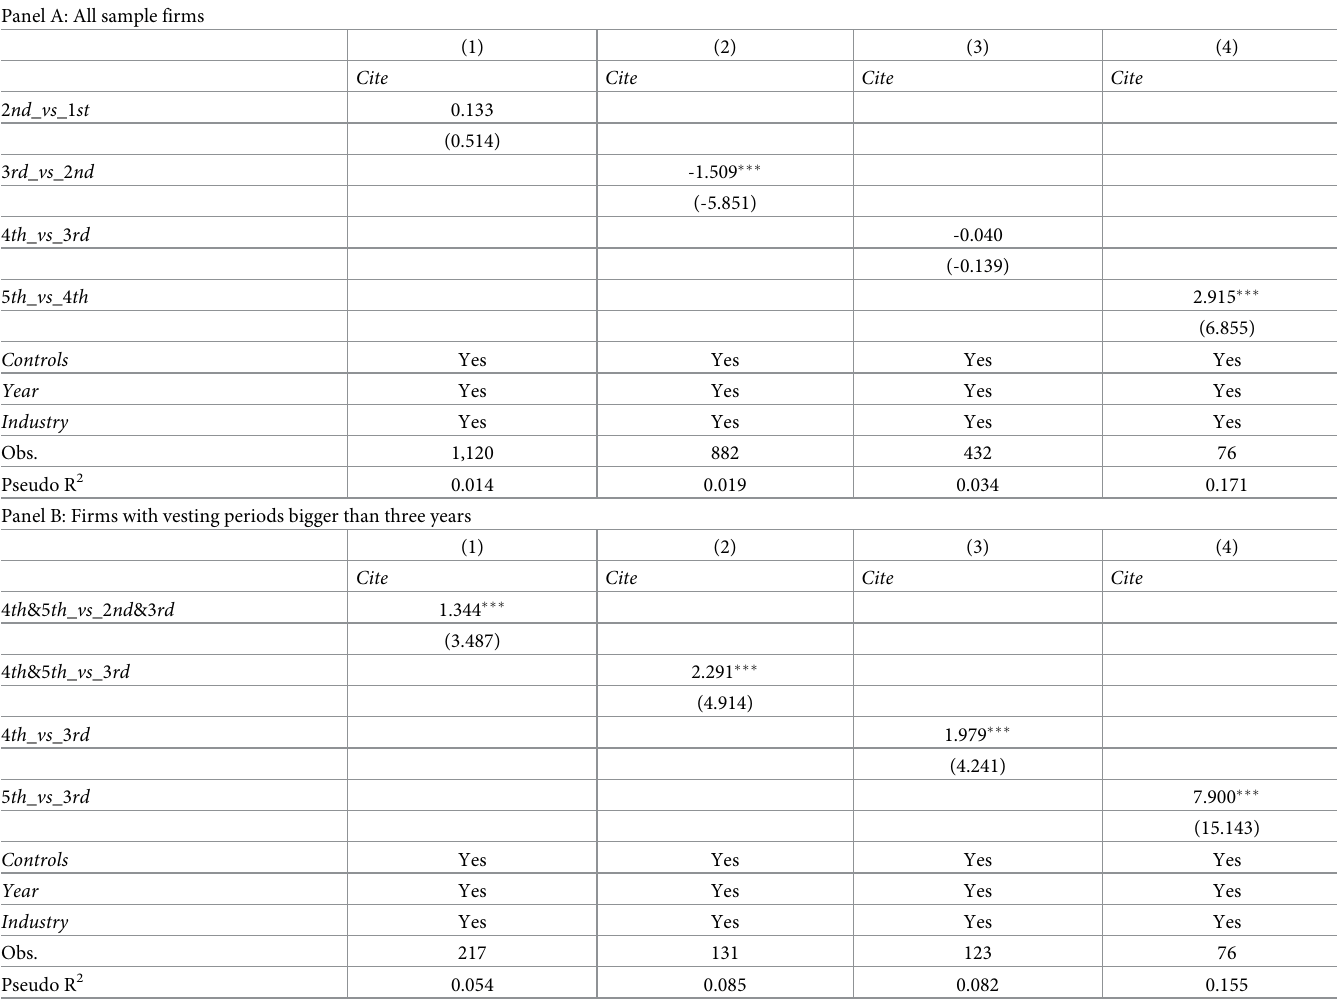
Table 3. Vesting periods and exploratory innovation strategy intensity: Time-series